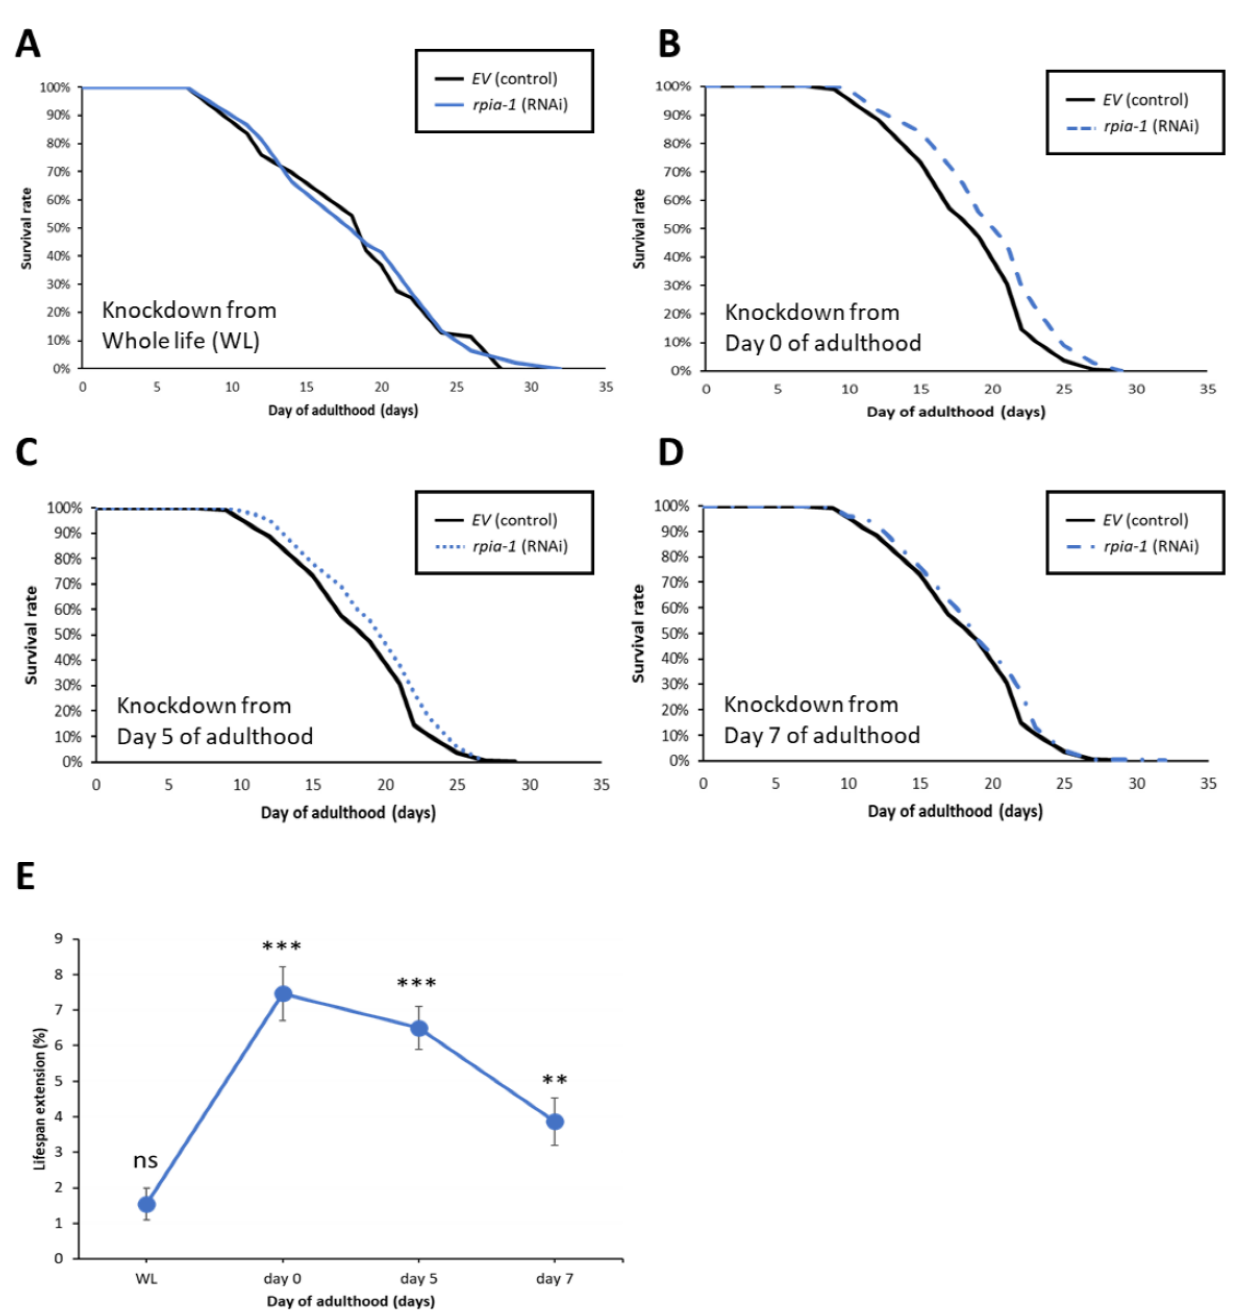
Figure 3. Knockdown of rpia-1 after developmental stage prolongs lifespan. In these lifespan experiments, solid black line represents the control group, and different blue lines represent the rpia-1 knockdown groups initiate at different time stage. ( A ) Ubiquitous knockdown of rpia-1 starting at the embryonic stage caused no lifespan extension, whereas ( B – D ) knockdown of rpia-1 after developmental stage at day 0, day 5, and day 7 resulted in 7.5%, 6.5%, and 3.9% in mean lifespan extension, respectively (**, p < 0.01; ***, p < 0.001, by log-rank test). ( E ) Among the three different time points of onset of rpia-1 knockdown, the knockdown initiated on day 0 resulted in the largest amount of lifespan extension.